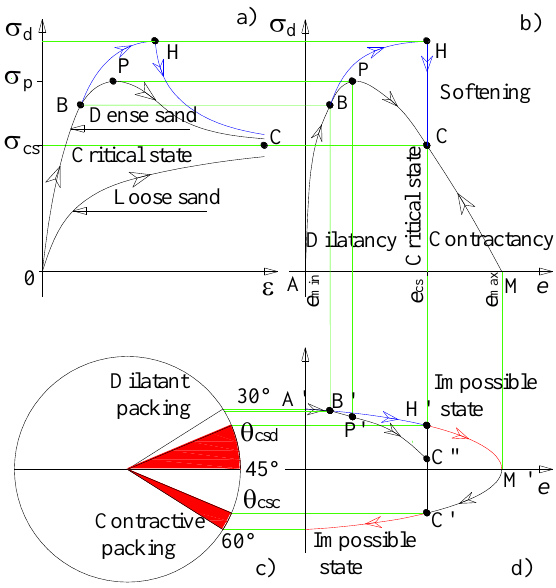
Fig. 2 . Mapping of plots. a) Experimental stress-strain curves of dense and loose sands, b) Casagrande´s plot [12], c) Angle of assemblage for the sphere points of contact, and d) Plot of equation (1). Black lines refer to dense soil with strain localization, and blue lines, to soil with homogeneous